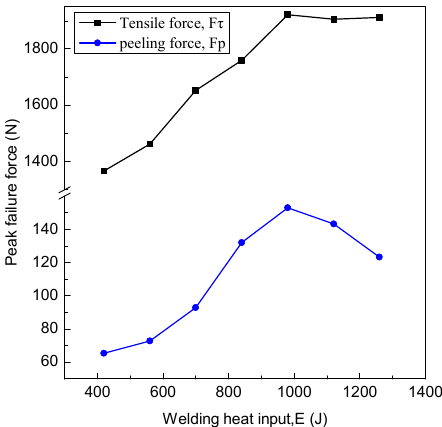
Figure 8. Tensile and peeling peak failure load with different welding heat inputs.